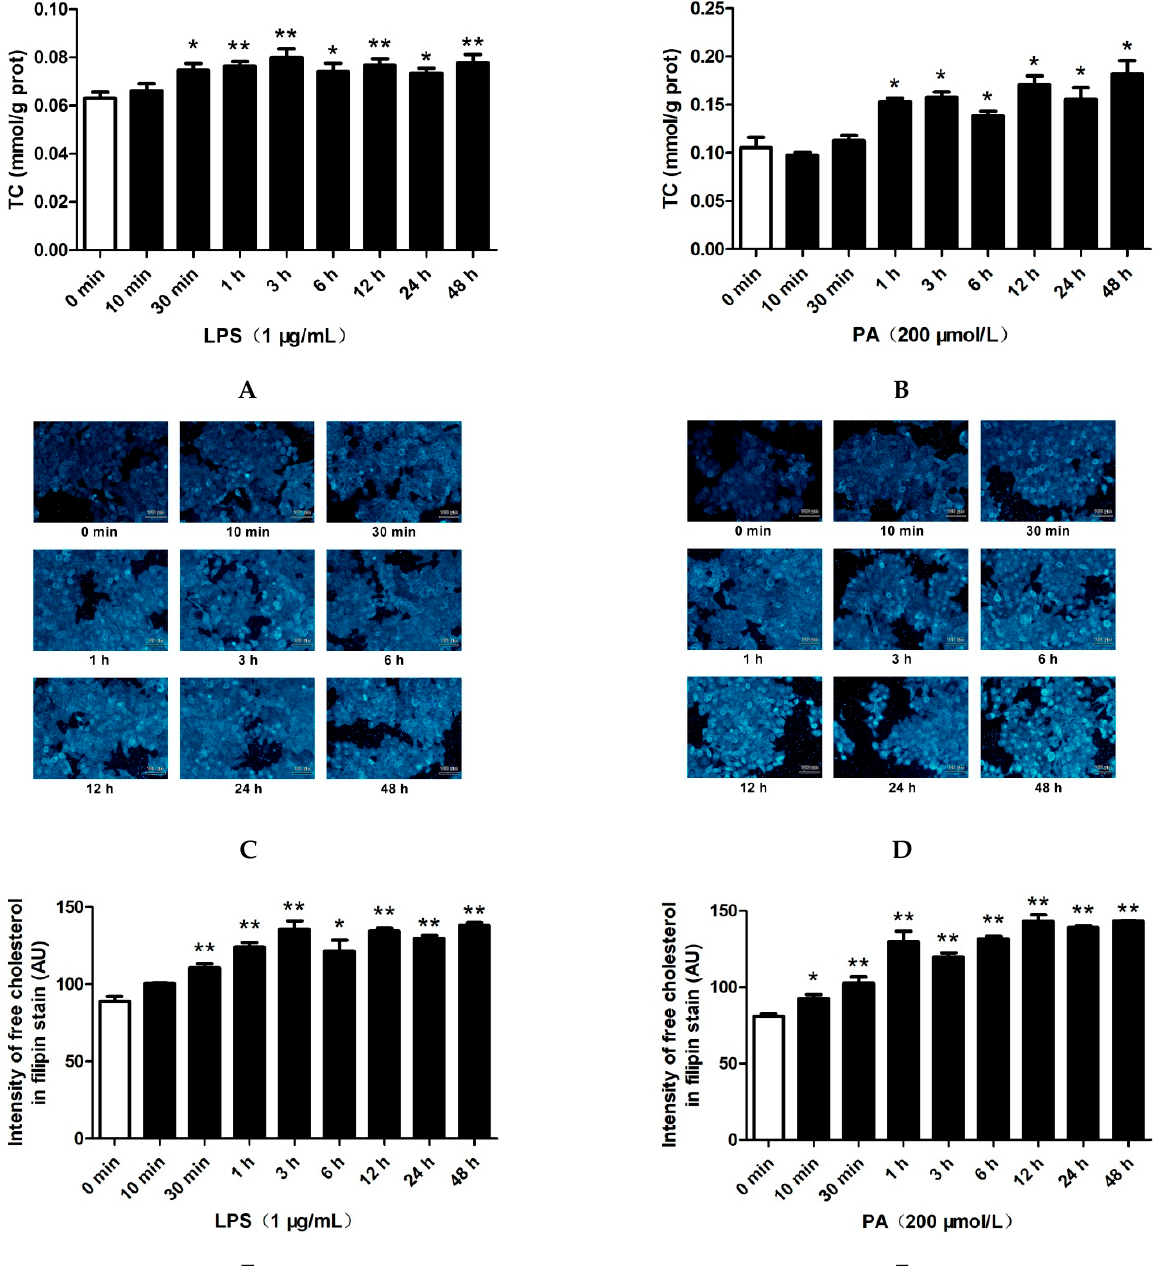
B Figure 1. Effects of LPS and PA on the viabilities of HepG2 cells. Cells were treated with 1 μ g/mL LPS ( A ) or 200 μ mol/L PA ( B ) for different times (0 min, 10 min, 30 min, 1 h, 3 h, 6 h, 12 h, 24 h, and 48 h). MTT assays were performed to determine the cell viability. The results are presented as means ± SD in triplicate ( n = 6); *: p < 0.05 vs. 0 min; **: p < 0.01 vs. 0 min. 2.2. LPS and PA Treatments Increased Cholesterol Content in HepG2 Cells As shown in Figure 2A,B, LPS treatment for 30 min to 48 h and PA treatments for 1 h to 48 h significantly increased the total cholesterol (TC) levels in HepG2 cells. Filipin